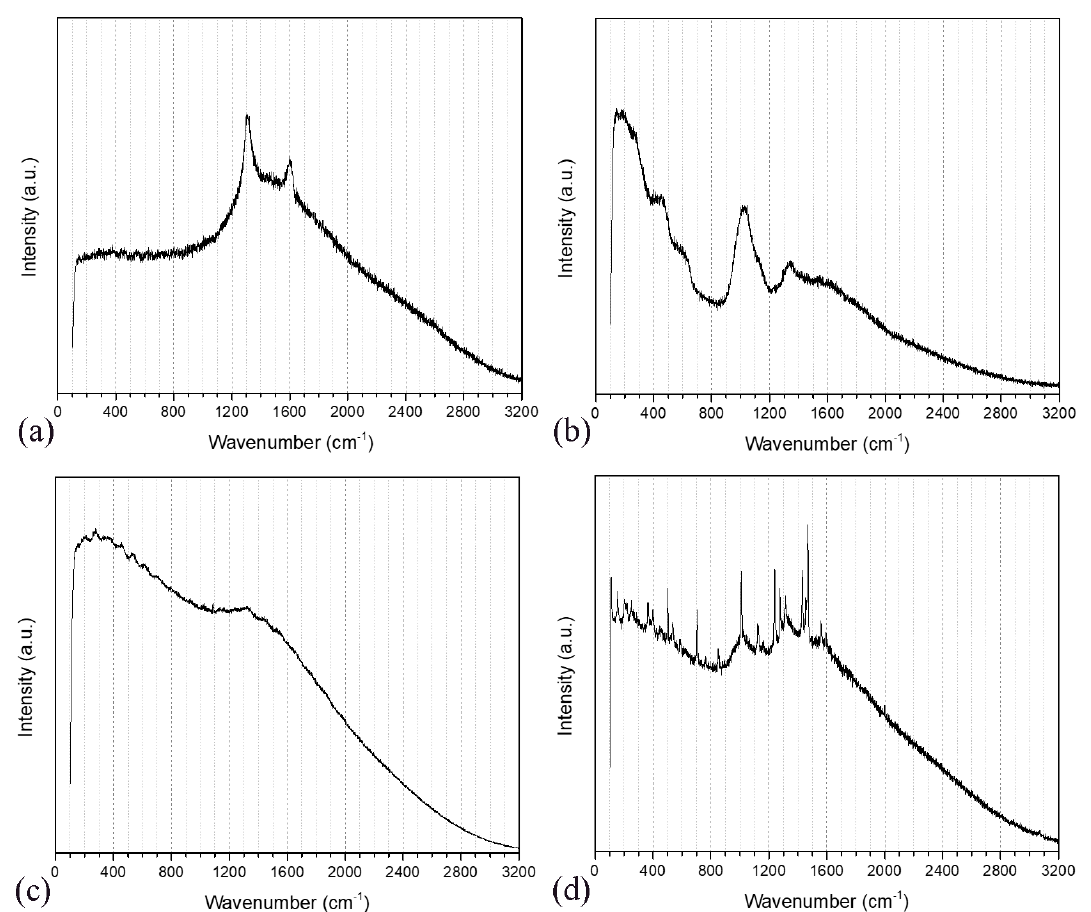
Figure 12. Raman spectra of the mild steel panels after subjection in 3.5 wt % NaCl for 96 h: ( a ) Steel–NaCl–blank , ( b ) Steel–NaCl–Na 2 HPO 4 , ( c ) Steel–NaCl–MBT , ( d ) Steel–NaCl–Na 2 HPO 4 –MBT .